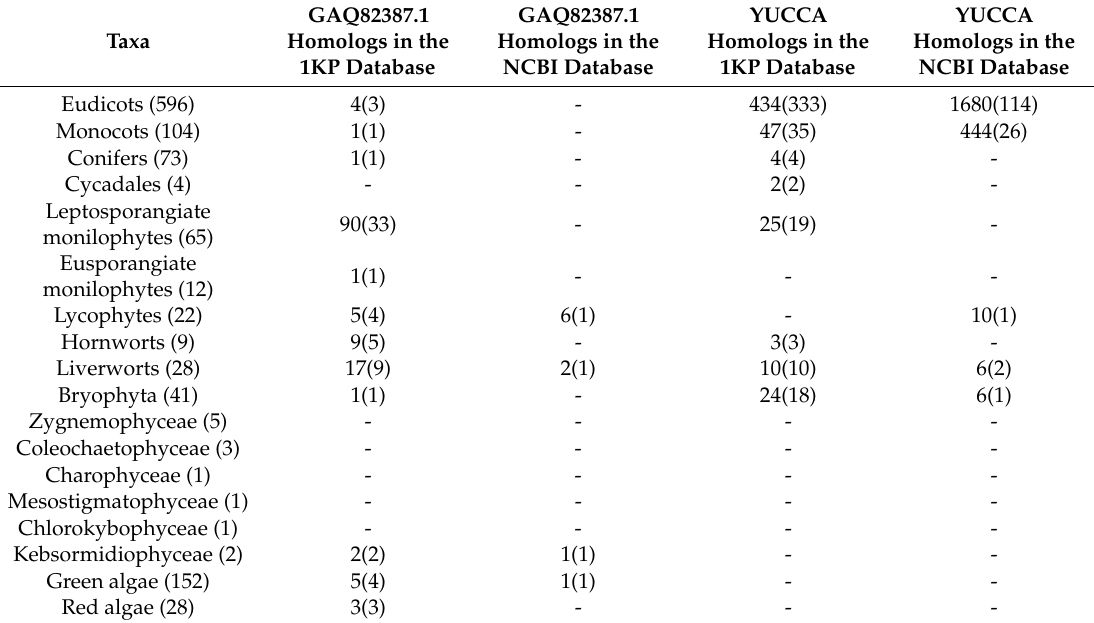
Table 2. The search for the homologs of K. nitens GAQ82387.1 (type IIb FMO group) and A. thaliana YUC2 AT4G13260 (YUCCA group) in the 1KP and NCBI